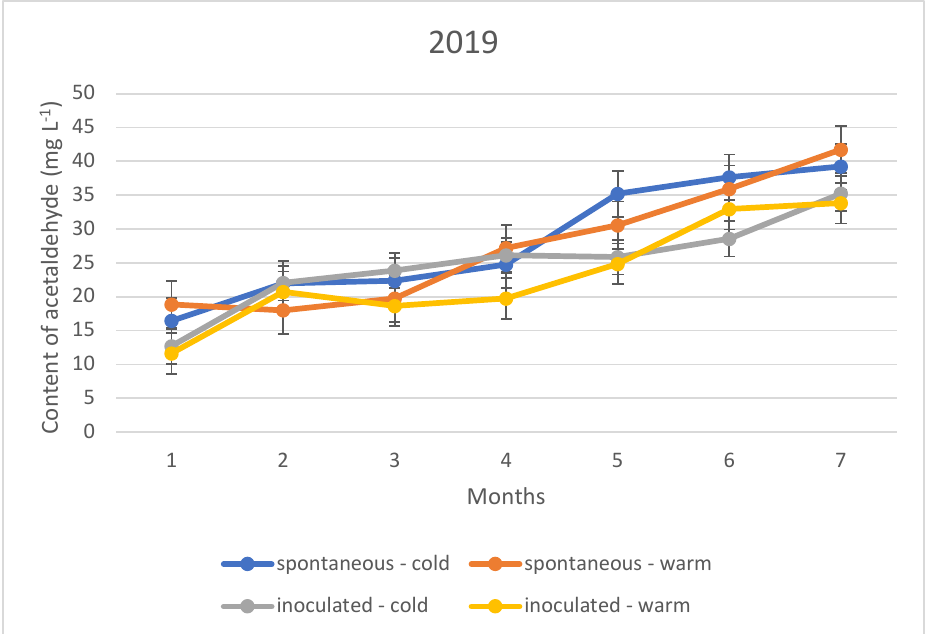
Figure 5. Acetaldehyde content of the wines tested during storage in 2018.